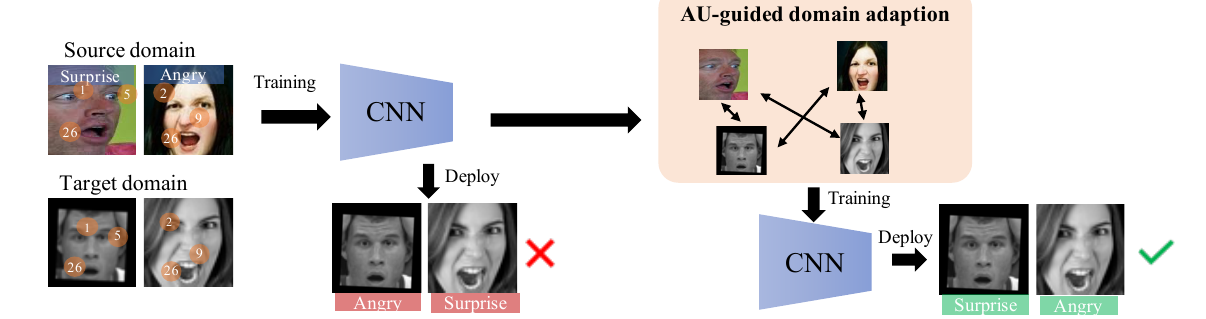
Figure 1. Illustration of unsupervised domain-adaptive facial expression recognition. A model trained on a source domain usually fails on a target domain due to subjective inconsistent annotations and different imaging conditions. AdaFER leverages the objective facial action units for auxiliary training, effectively relieving the annotation bias between source and target